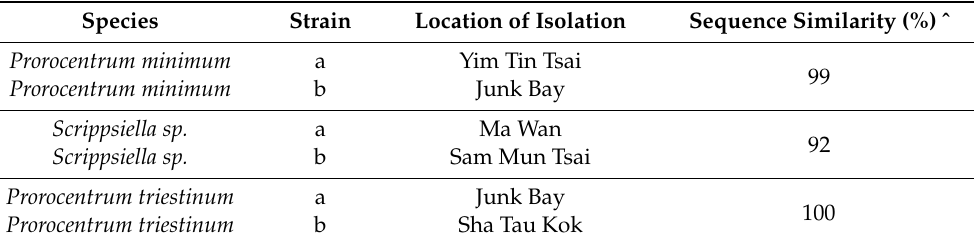
Table 2. Sequence analysis of dinoflagellate strains of the same species.